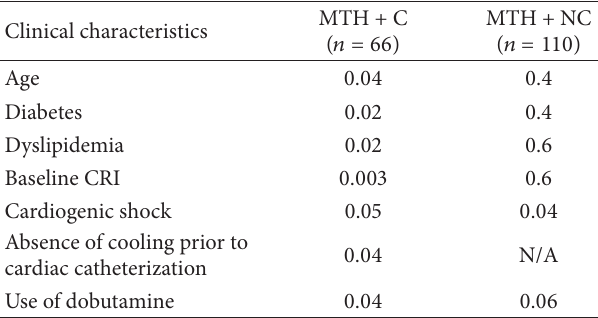
Table 4: Univariate predictors of in-hospital mortality for study population ( 𝑛 = 176